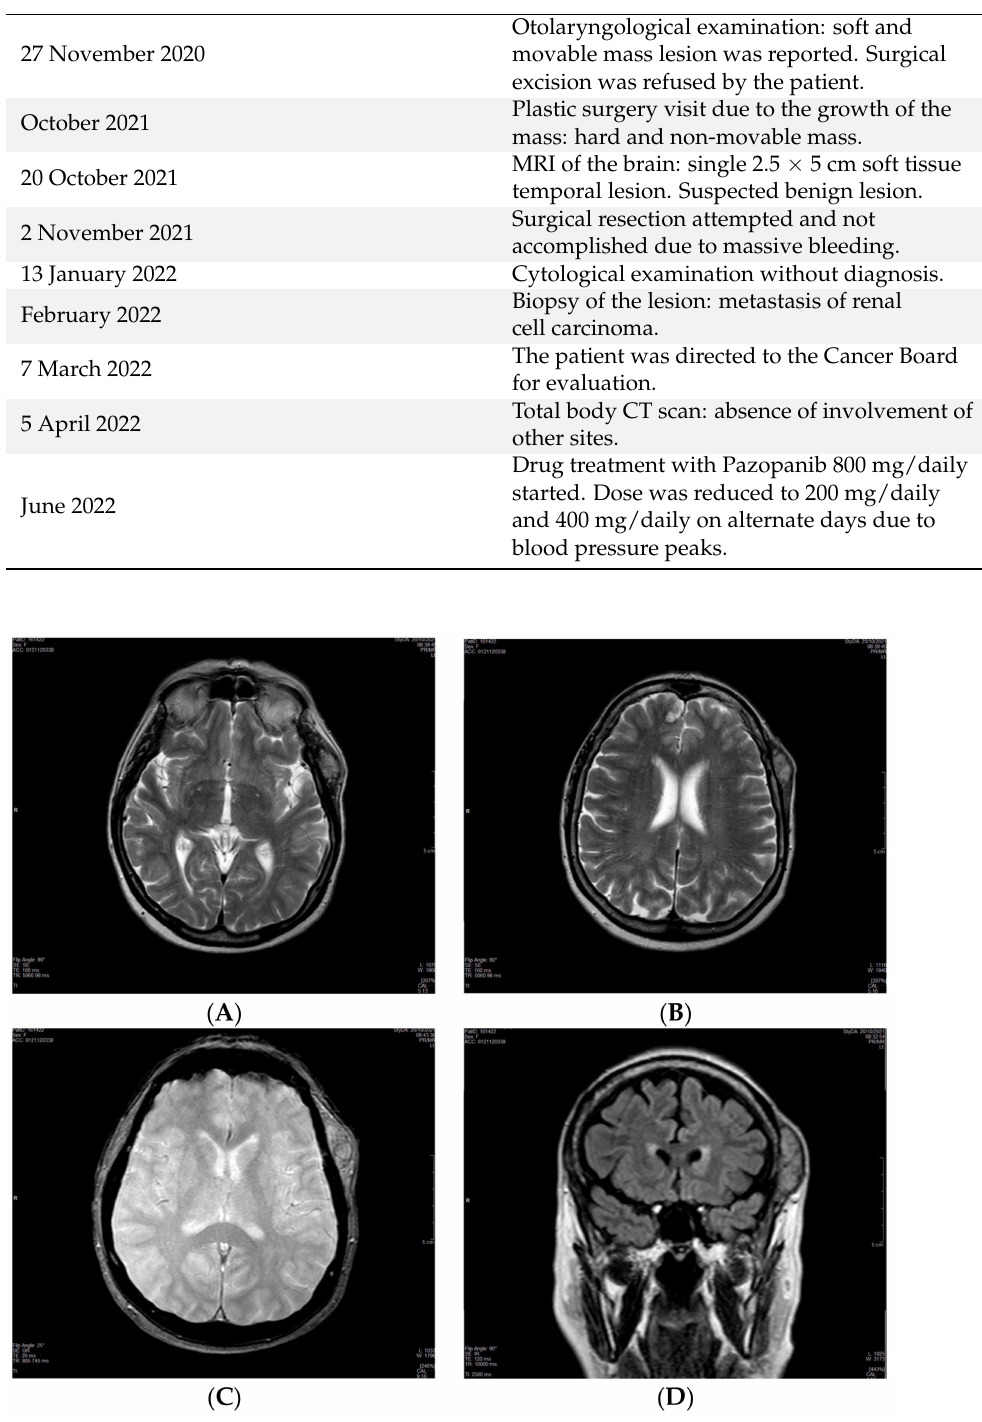
Figure 1. MRI in the axial ( A – C ) and coronal plane brain ( D ) shows a single 2.5 × 5 cm soft tissue temporal lesion in the left side with moderate contrast impregnation ( C